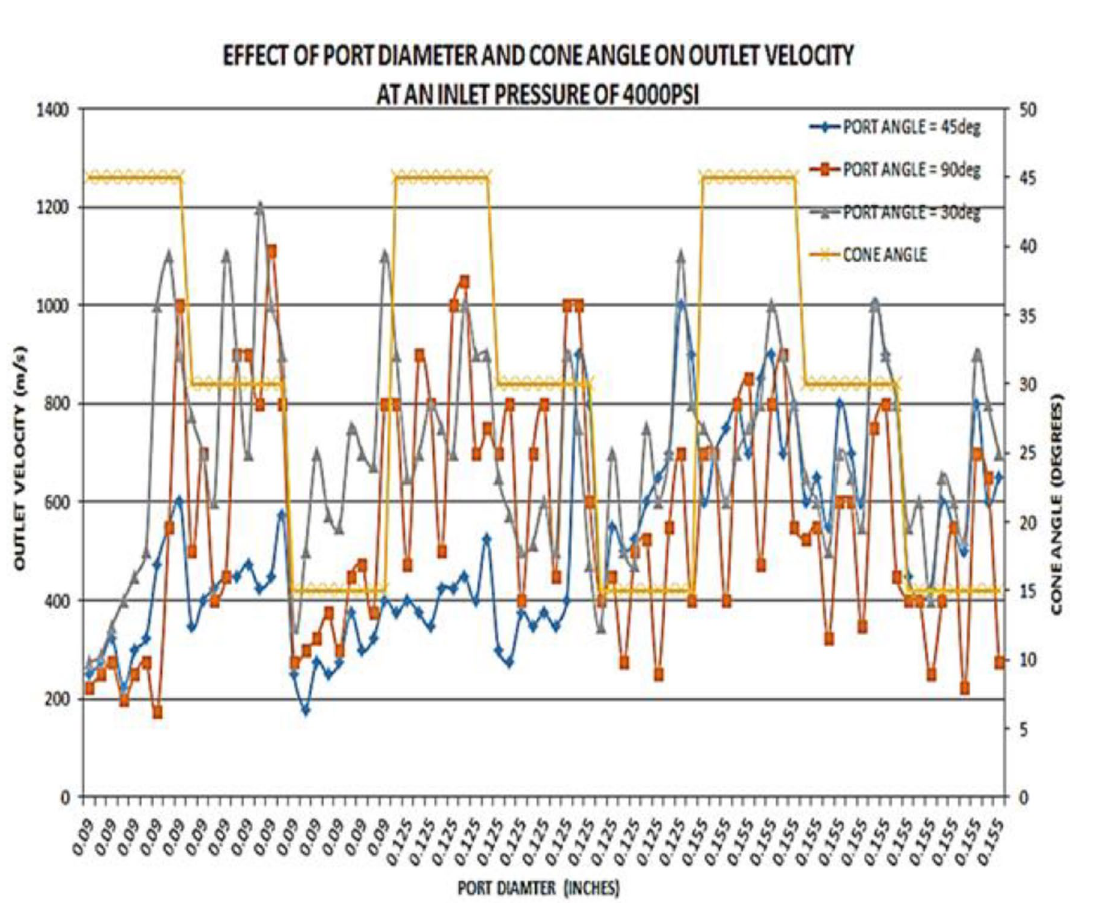
Fig. 9 Effect of port diameter and cone angle on outlet velocity at an inlet pressure of 4000